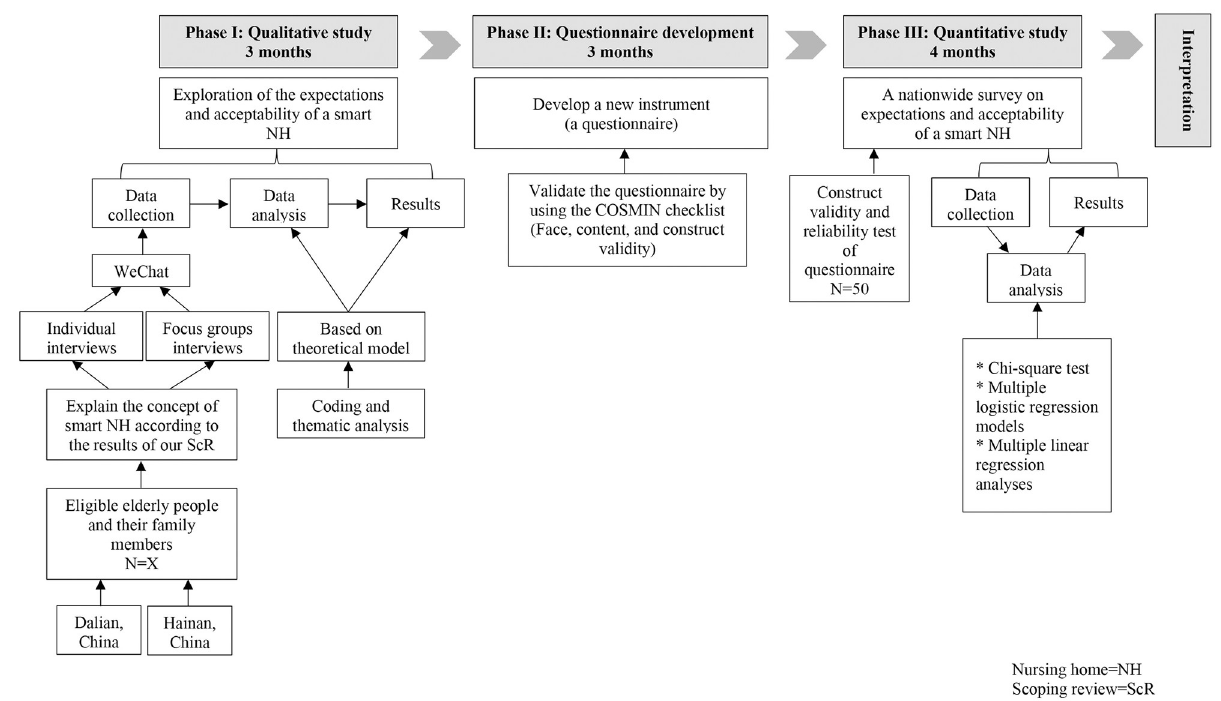
Fig 2. Exploratory sequential mixed methods study